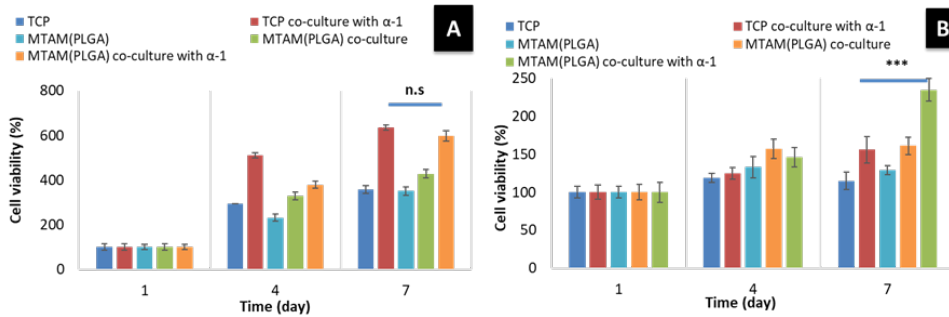
Figure 6. Cell viability of the co-culture of SMCs ( A ) and HUVEC ( B ) in mediums with and without Haptaglobulin α-1. In the presence of Haptaglobulin α-1, a significantly higher cell viability for both SMCs and HUVECs were observed when co-cultured using the PLGA MTAMs (sample size n = 3). *** means significant.